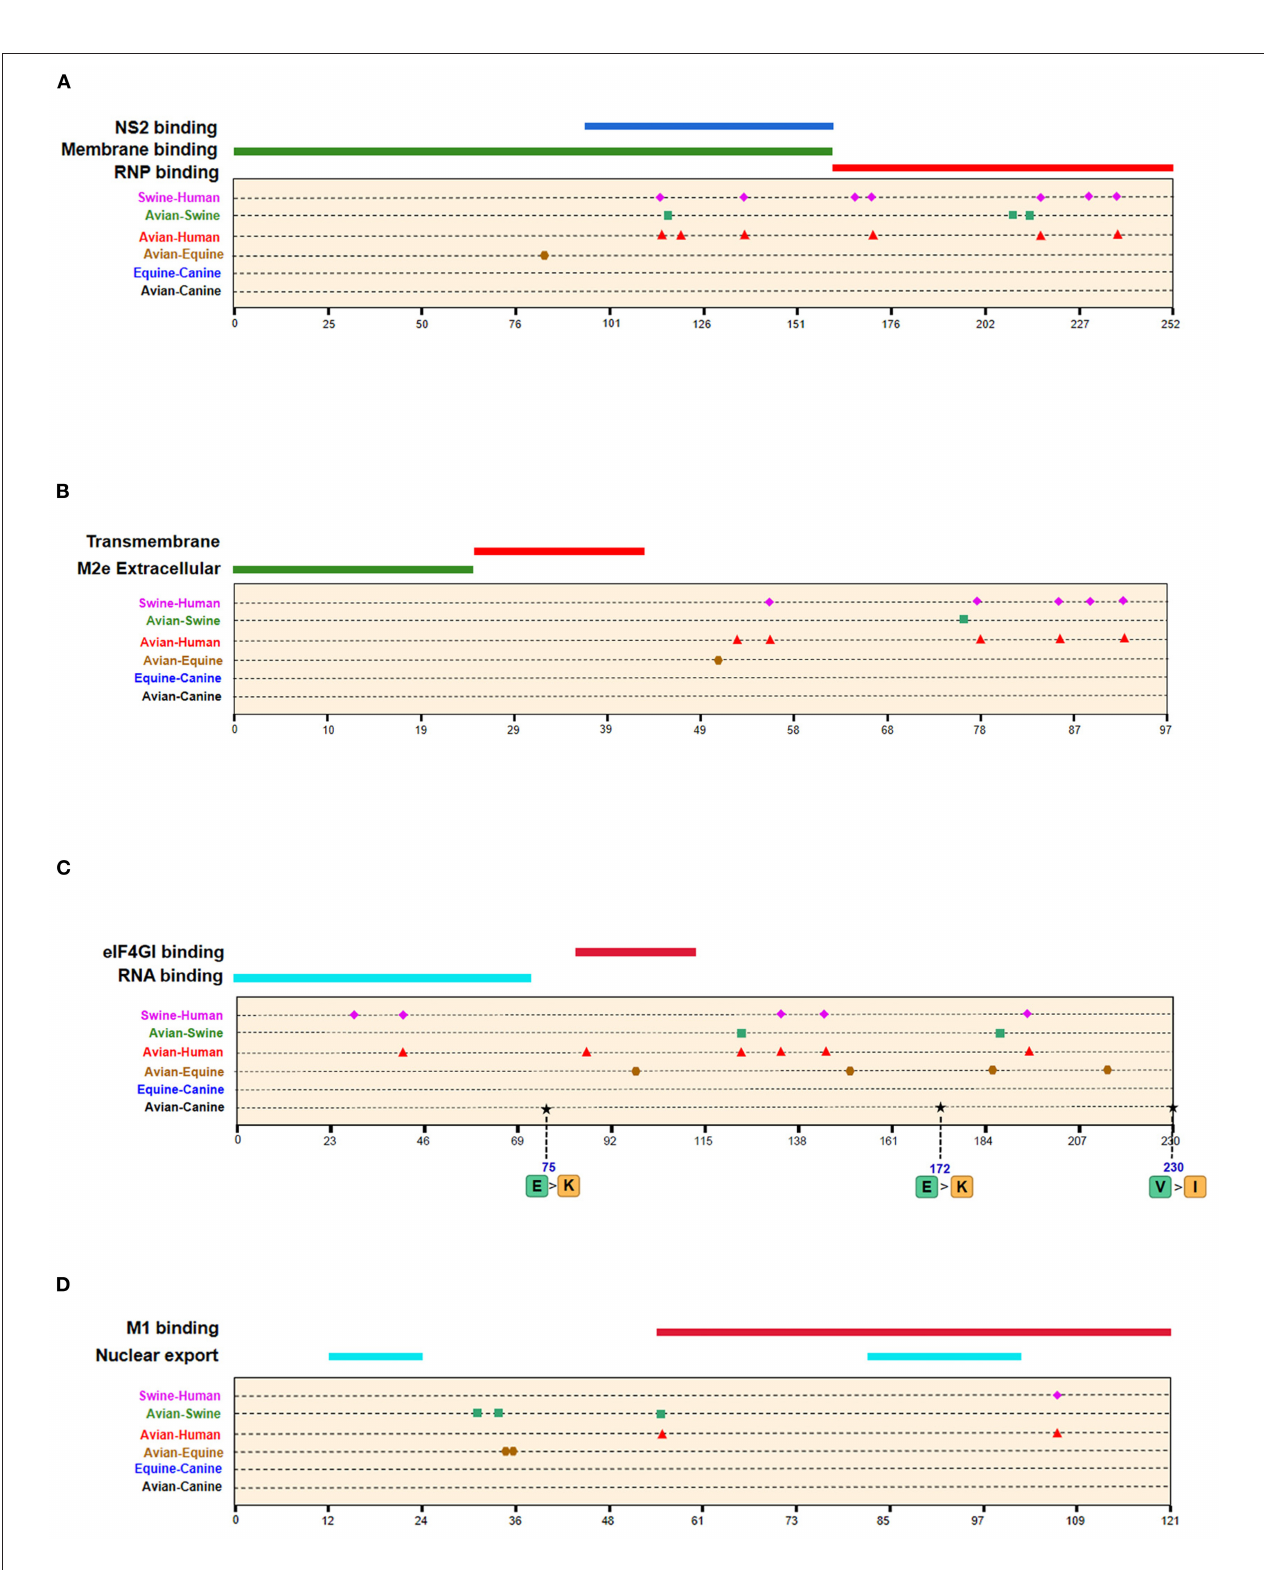
FIGURE 6 | Positions of identified signatures in structural and functional domains of M1 (A) , M2 (B) , NS1 (C) , and NS2 (D) proteins. The positions and dominant amino acid residues of Avian → Canine (H3N2) signatures are placed below the pale-yellow bar. Black star: Avian → Canine (H3N2), blue circle: Equine → Canine (H3N8), brown hexagon: Avian → Equine (H3N8), red triangle: Avian → Human (H3N2), green square: Avian → Swine (H3N2), and purple triangle rhomb: Swine → Human (H3N2). The detail of these signatures are in Table 2 .